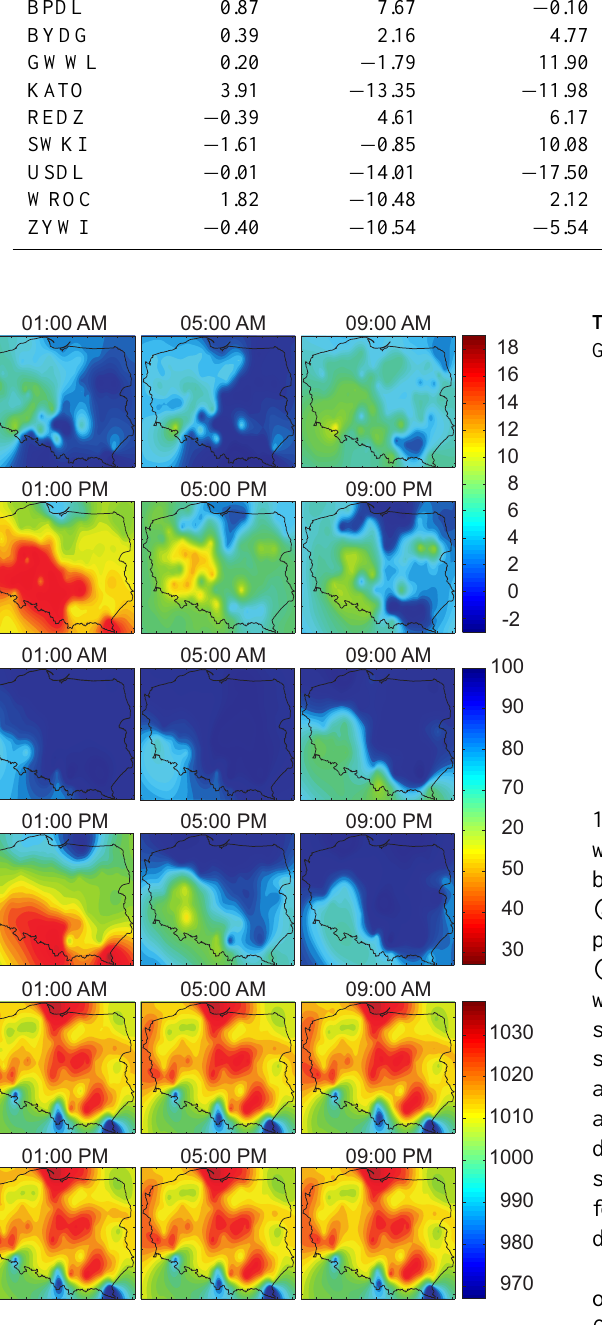
Fig. 5. Meteorological parameters interpolation for the area of Poland on 7 November 2011. Each map combines interpolated and measured data.